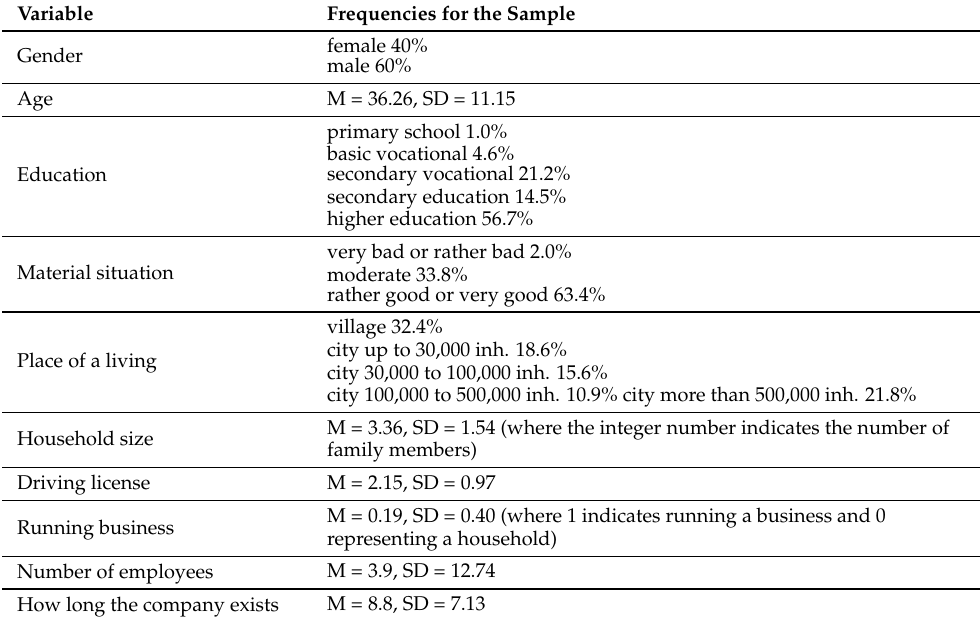
Table 1. Sociodemographic